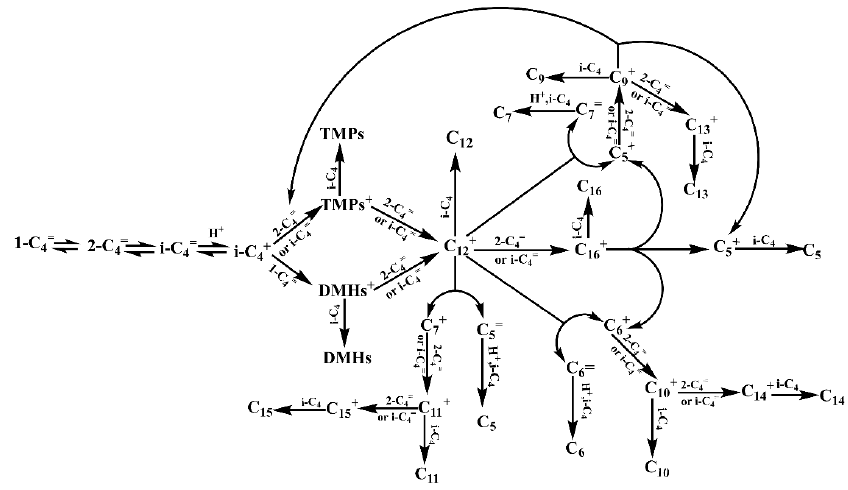
Figure 3. Diagram of the isobutane/2-butene alkylation reaction pathway network.